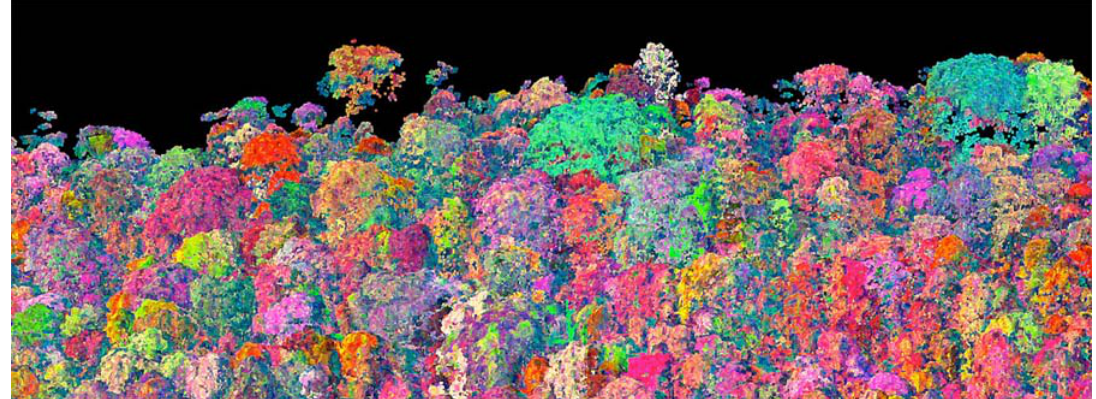
Figure 1. This 3-D spectroscopic image of a Panamanian rainforest was acquired through fused waveform LiDAR and high-fidelity imaging spectrometer measurements from the Carnegie Airborne Observatory (CAO; http://cao.ciw.edu). The image reveals the detailed biological, functional and structural diversity of the rainforest, with different colors quantitatively indicating variation in growth and defense chemicals within the foliage of co-existing trees and